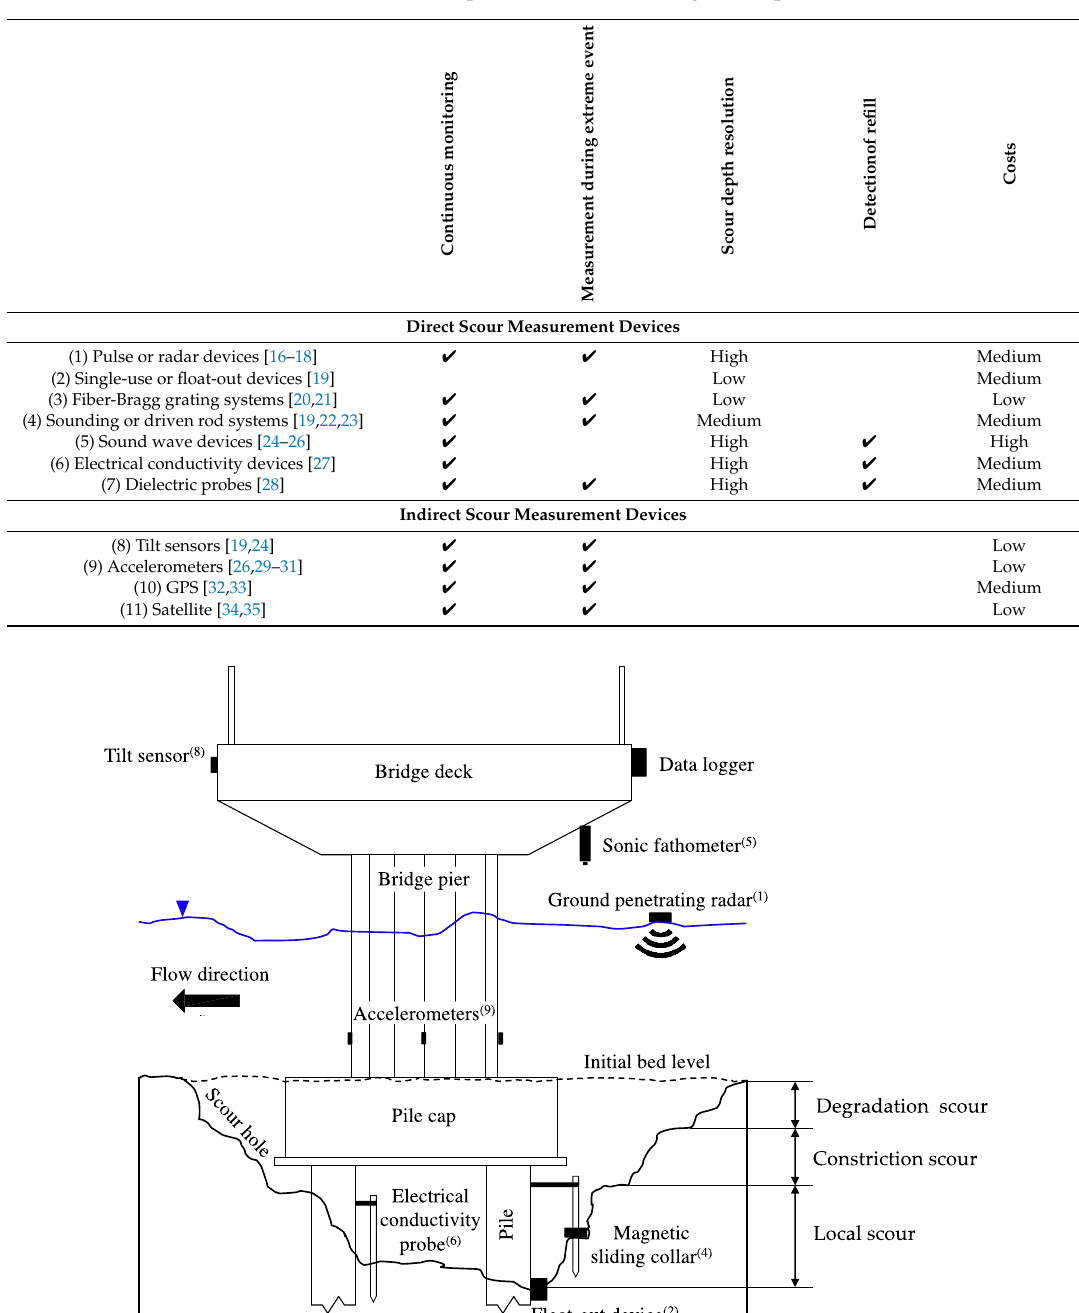
Table 1. Most widespread scour monitoring techniques.